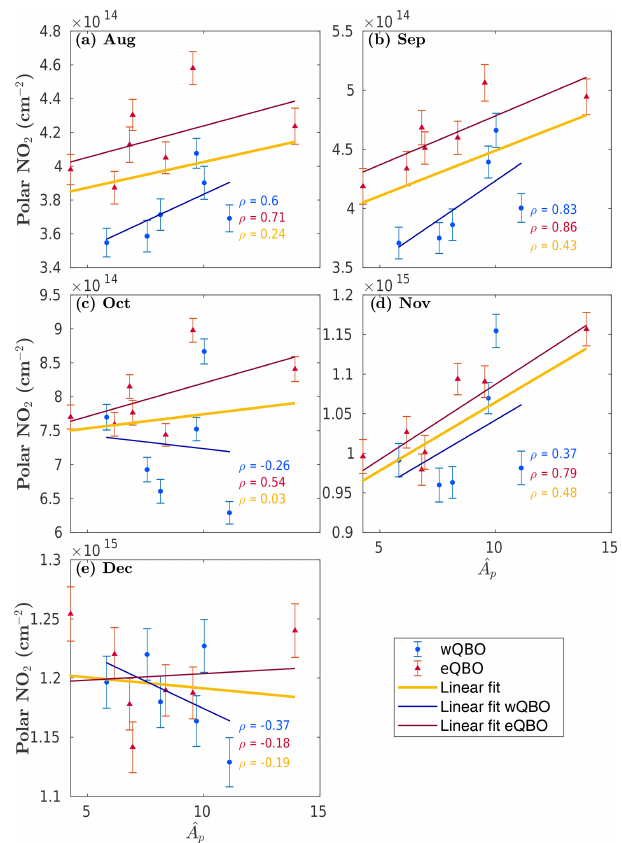
Figure 4. ˆ A p vs. the monthly average cos ( latitude ) area-weighed NO 2 column density averaged over the region from 60 to 90 ◦ S (where available, see text) from August to December (months are shown as individual panels). Red triangles indicate years with eQBO, and blue circles indicate years with wQBO. The yellow line shows a least squares linear fit to all data, the red line shows the eQBO years only, and the blue line shows the wQBO years only. The Spearman ρ (correlation coefficient) for each set is shown in each panel using the corresponding colour, e.g. red ρ corresponds to the correlation coefficient for eQBO years. Error bars are ±